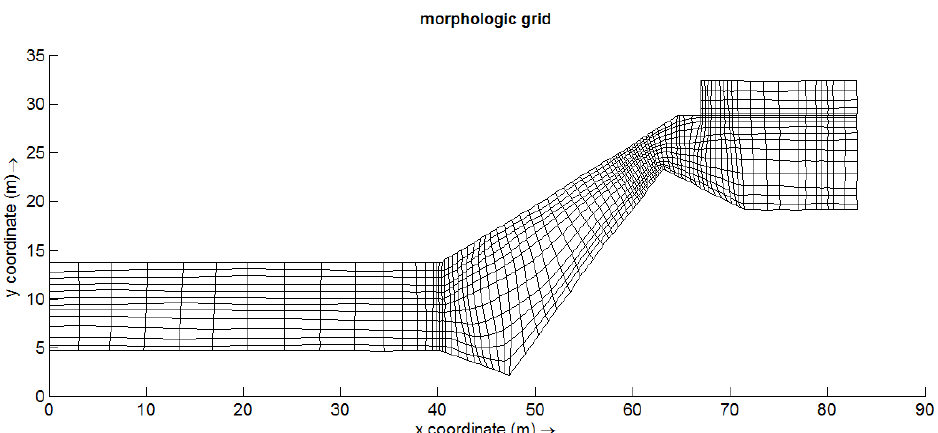
Figure 9. Grid used for numerical